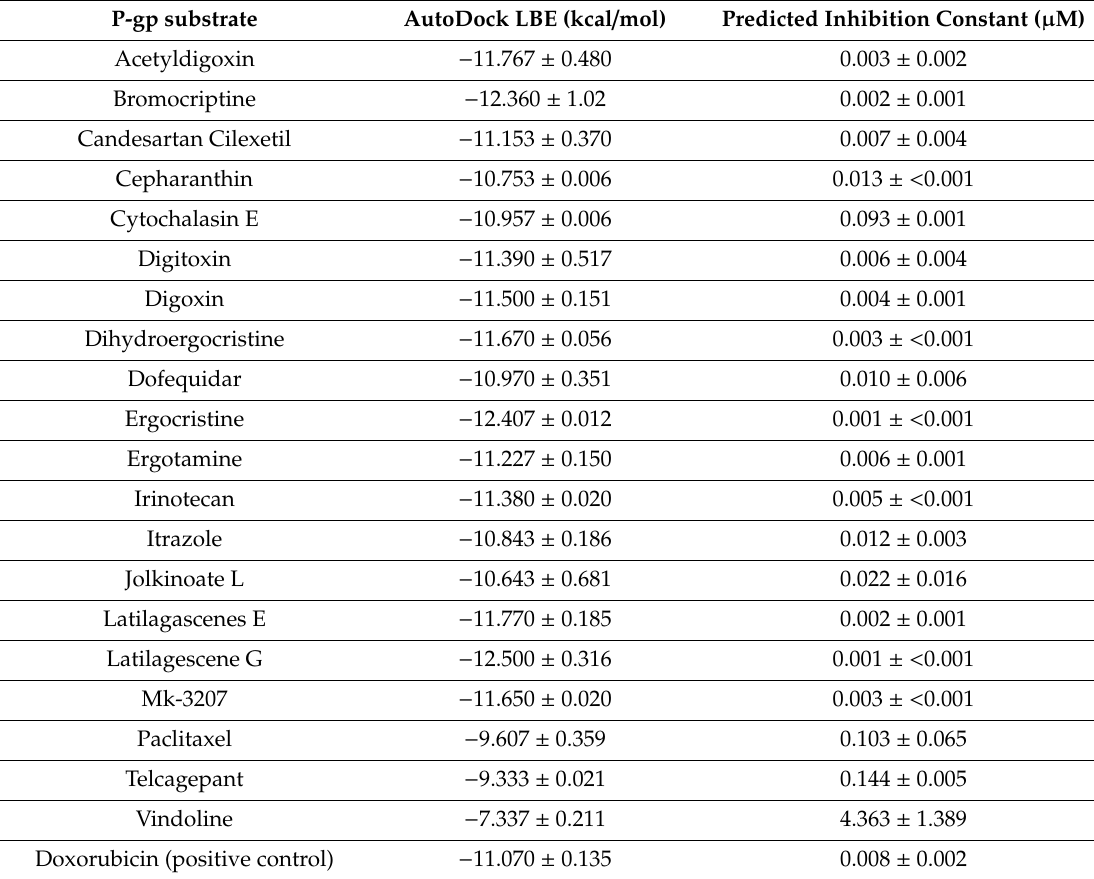
Table 9. Lowest binding energies (LBE) and predicted inhibition constants obtained by molecular docking of the top 20 P-gp substrates.